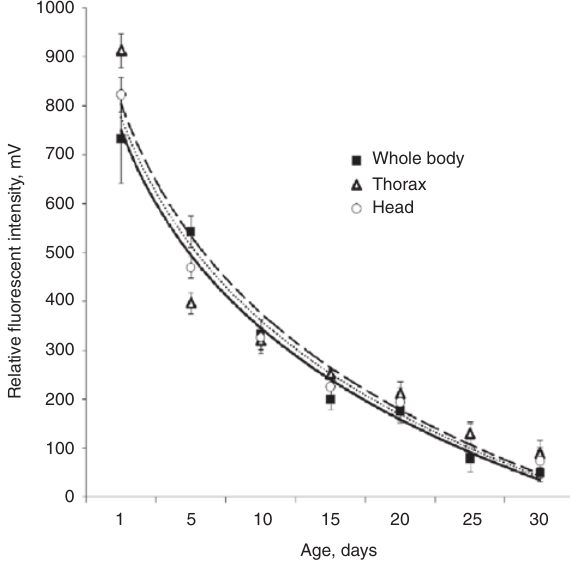
Figure 2: Comparison of the alteration of pteridines compounds of the whole body, head and thorax of Anopheles staphensi females during 30 days.